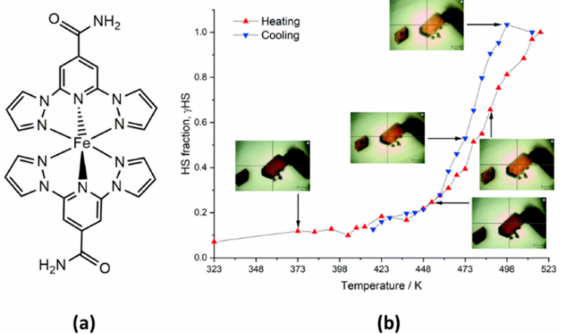
Figure 12. ( a ) Structural drawing of [Fe(bppCONH 2 ) 2 ](BF 4 ) 2 ( 16 ), where bppCONH 2 is 2,6- bis(pyrazol-1-yl)pyridine-4-carboxamide; the BF 4 anions existing in the lattice are eliminated. ( b ) Calculated HS population as a function of temperature for both heating (red scatter points) and cooling (blue scatter points) modes extracted by Raman spectroscopy. ( b ) is reproduced from Ref. [97] with permission from the Royal Society of Chemistry.